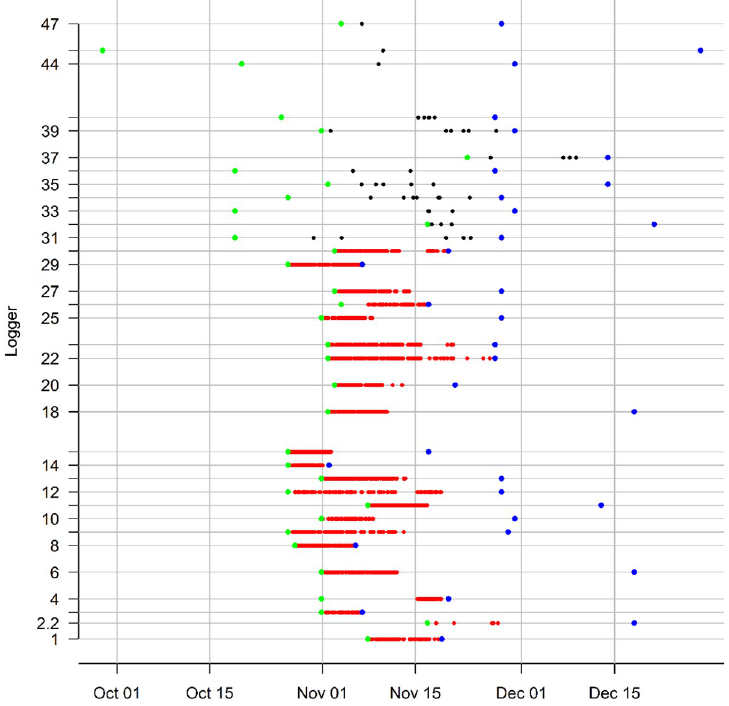
Fig 2. Distribution of total time in pairing for all observed pairs of rabbits classified by age class. Solid symbols and lines denote group averages and 95% confidence intervals.